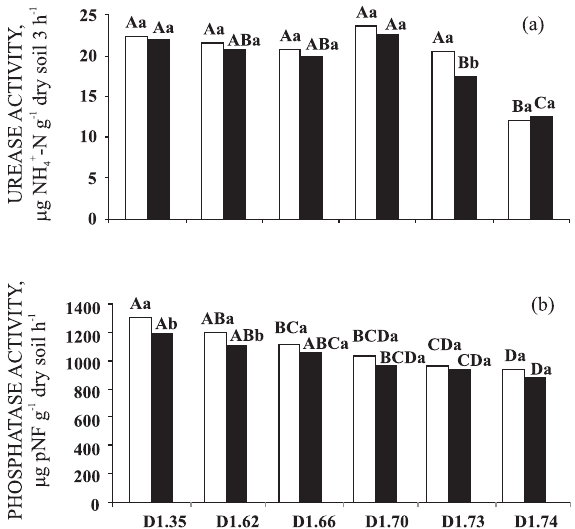
Figure 4. Urease (a) and acid phosphatase (b) activities found in the layers 0–10